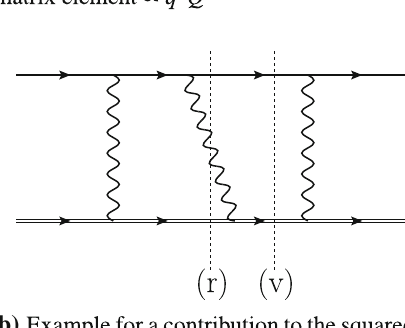
( 1 ) (r), and M n n + 1